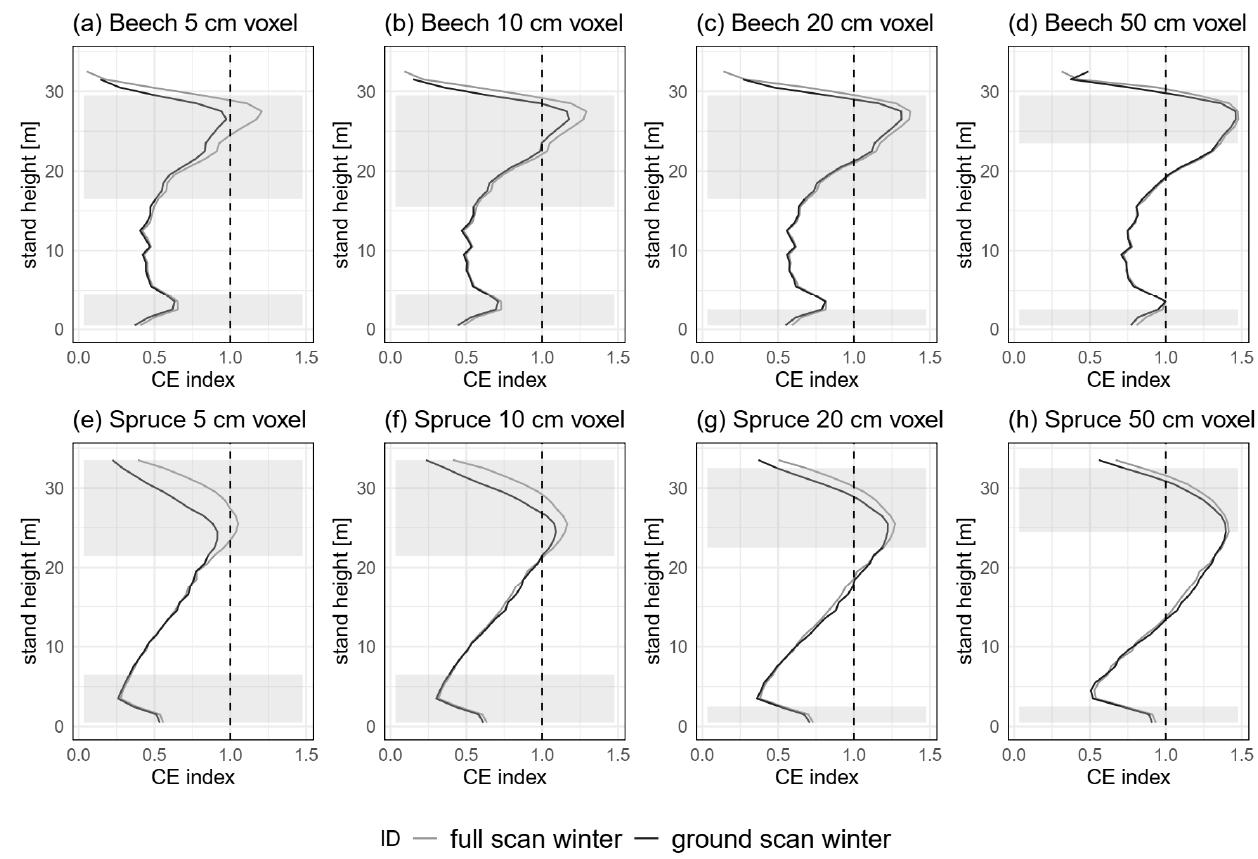
Figure 10. CE indices for beech ( a – d ) and spruce ( e – h ) stands for the ground and full scans from winter over the height range. The black curve shows the plot for the ground scan, and the gray curve show the plot for the full scan. The curves are based on six circular subplots, each with a radius of 5 m. Shaded in gray is the height range in which the scans differ significantly from each other.